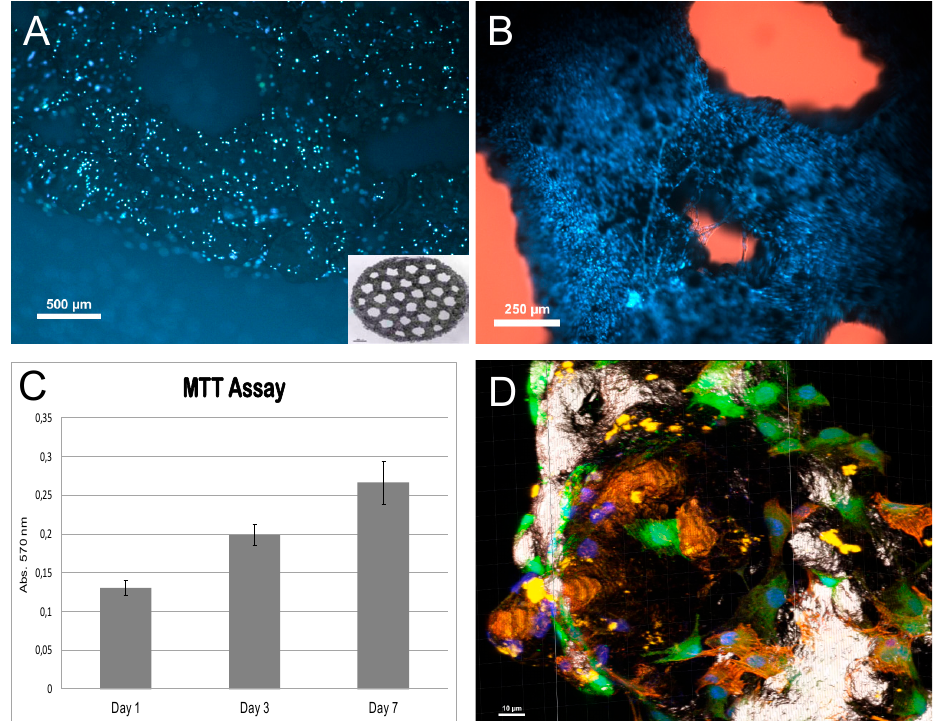
Figure 5. The in vitro evaluation. ( A ) and ( B ) Hoechst staining showing the nuclei of living cells seeded onto titanium discs at 1 day and 7 days, respectively, after seeding. Insert in (A) shows one of the discs used for the in vitro assays (ø ≈ 13 mm). Note the different cell density between (A) and (B). ( C ) MTT assay of the preosteoblastic cell cultures. As seen in the graph, the population size increased progressively with time. ( D ) 3D-reconstruction of confocal planes of MCT3-E1 cells stained with CMFDA (5-chloromethylfluorescein diacetate) (green), Hoechst (blue), and TRITC-phalloidin (Phalloidin–Tetramethylrhodamine B isothiocyanate) (red). The titanium surface has been given a silver-gold pseudocolour. An animation of this figure can be found as Supplementary Data, where action microfilaments and cell bodies extension can be better observed.